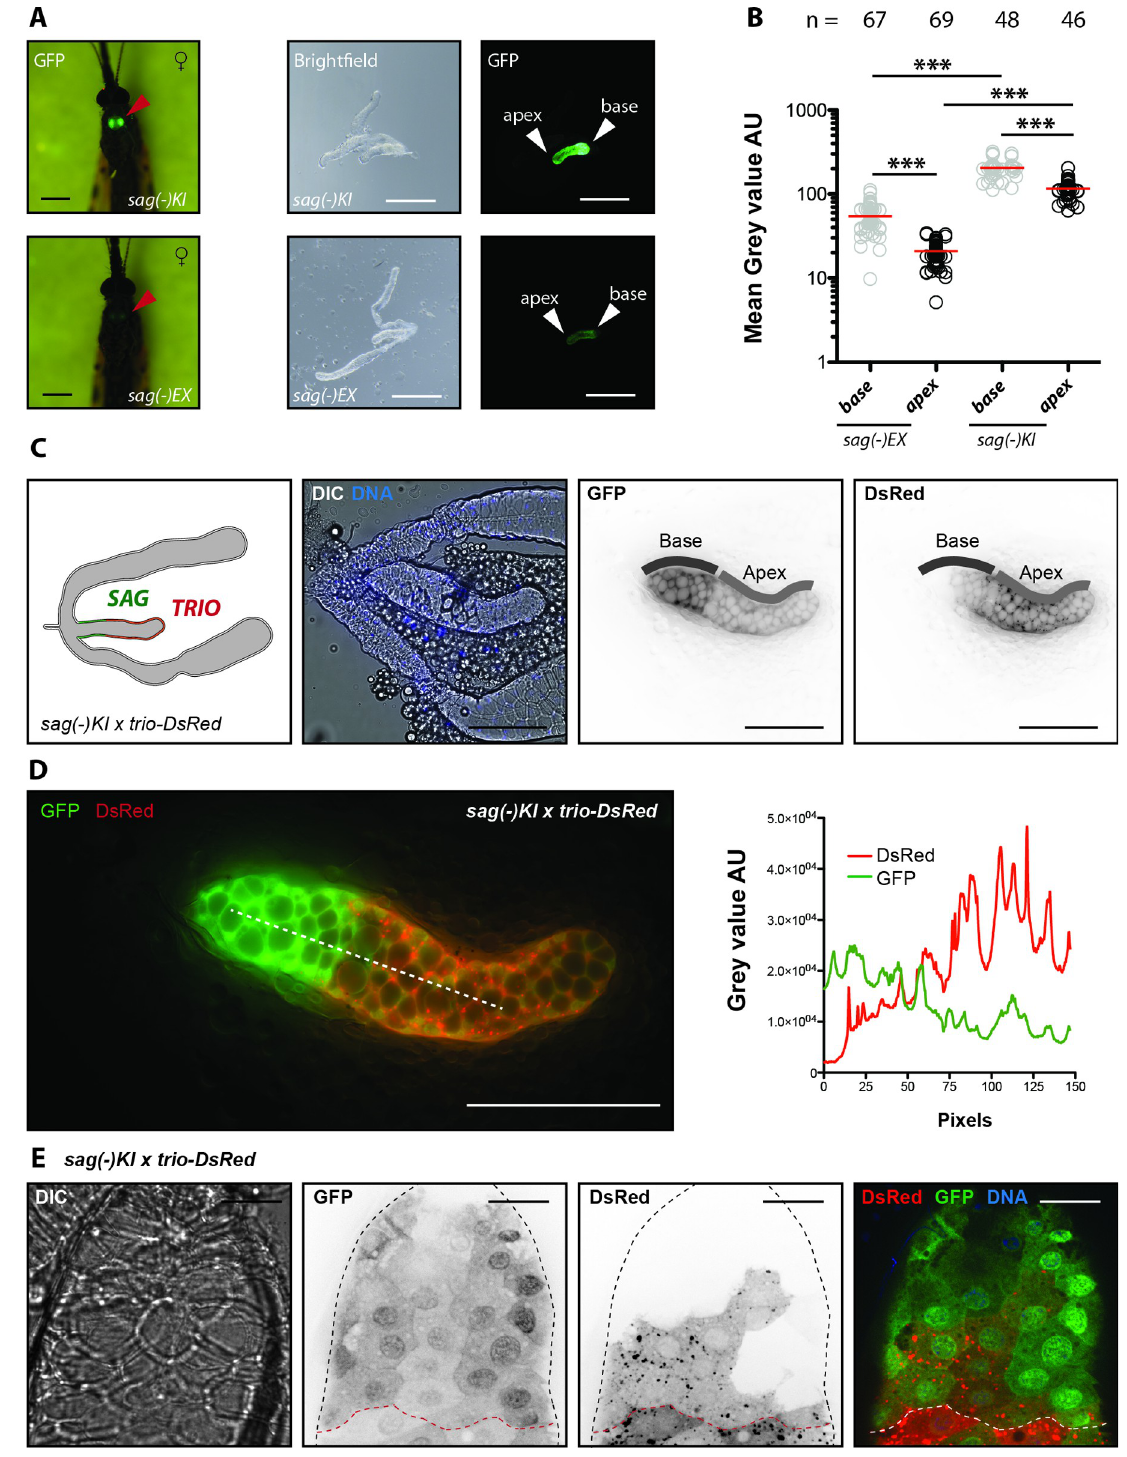
Fig 3. Fluorescent reporter expression in the median lobe reveals spatial expression differences of saglin and trio promoters. A) EGFP expression in homozygous sag(-)KI and sag(-)EX females seven days after emergence (left side). Red arrows point towards the location of the salivary glands. Scale bar: 0.5 mm. Brightfield and GFP signal in dissected salivary glands of homozygous sag(-)KI and sag (-)EX females (right side). Positions of the base and apex of the median lobe are indicated. Scale bar: 250 μ m. B) Mean EGFP fluorescence quantification at the apex and at the base of the median lobe of sag(-)EX and sag(-)KI salivary glands dissected after sugar feeding. The